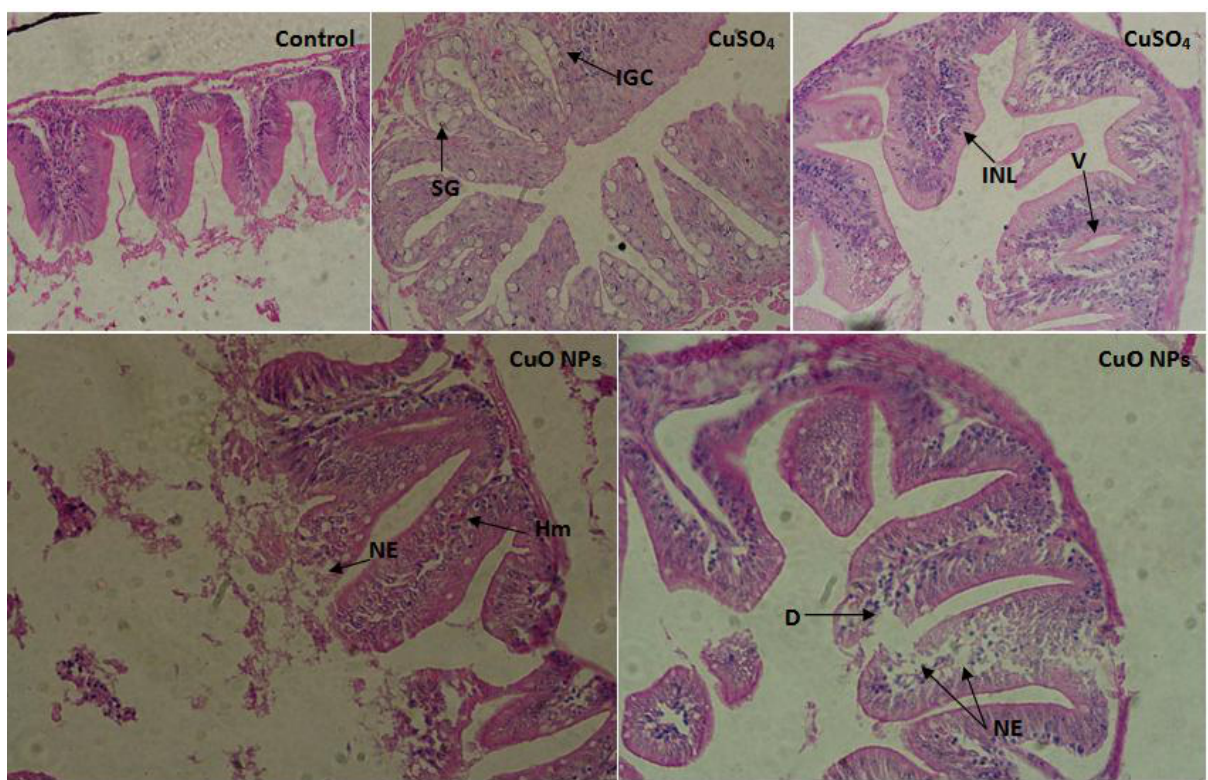
Figure 3. Histological alterations in the intestine of guppy after 10 days of exposure to CuO-NPs and Cu ++ (x40) The intestine of fish in the control group indicated only some minor histopathological alterations, whereas treatment groups showed injuries including degeneration (D), vacuolation (V), necrosis and erosion (NE), increase in the number of goblet cells (IGC), swelling of goblet cells (SG), hemorrhage (Hm), and increase in the number of lymphocyte (INL). Table 3. Summarized histopathological effects of 20 µg/l CuO-NPs and Cu ++ on the intestine of guppy